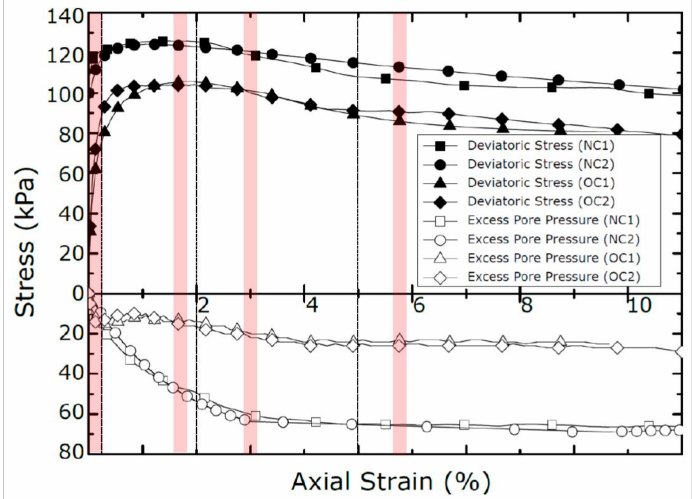
Figure 7. Stress–strain behavior for normally consolidated (NC) and over-consolidated (OC)